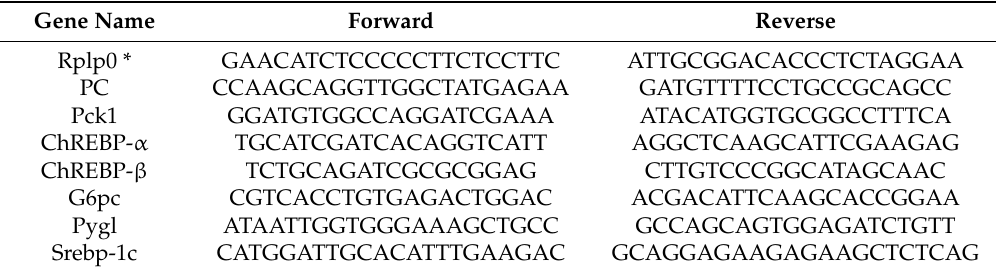
Table 2. Oligonucleotides used in qRT-PCR assays.